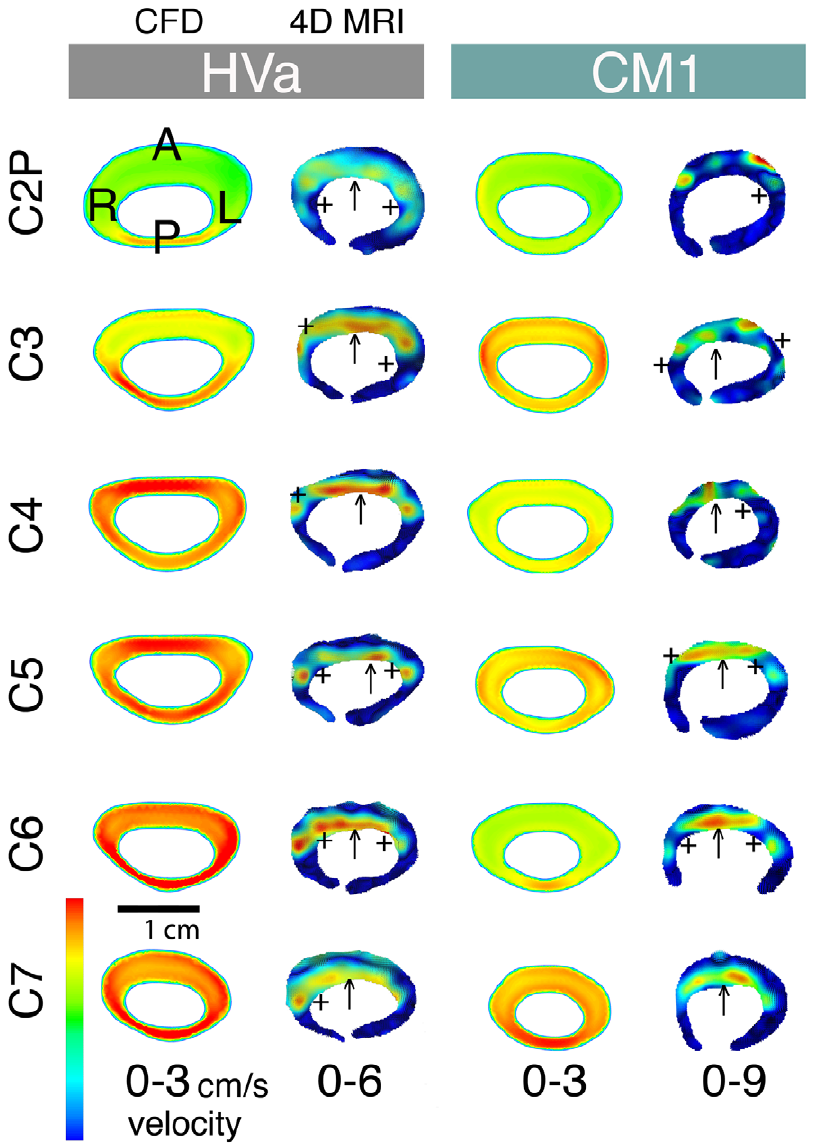
Figure 6. Peak-systolic thru-plane CSF velocity profiles for a healthy subject and a CM patient. Comparison of the peak systolic thru- plane CSF velocity profiles between the 4D PC MRI and CFD for HVa (left) and CM1 (right). Note the different velocity scales for each plot (optimized for visualization of flow profiles in each case). Colors indicate the magnitude of thru-plane velocities. q symbols highlight the elevated anterior CSF velocities in comparison to the posterior that were observed in all of the 4D PC MRI velocity profiles (healthy and patients). The posterior versus anterior flow differences were not present in the CFD simulations (see Figure 5). + symbols indicate locations where the nerve roots appear to local CSF